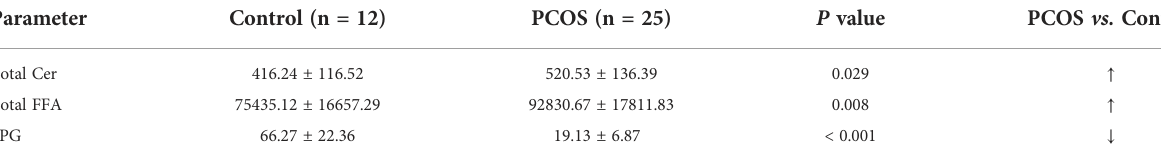
TABLE 2 Changes in the relative levels of candidate lipids in the FF for discrimination between women with PCOS and without PCOS.